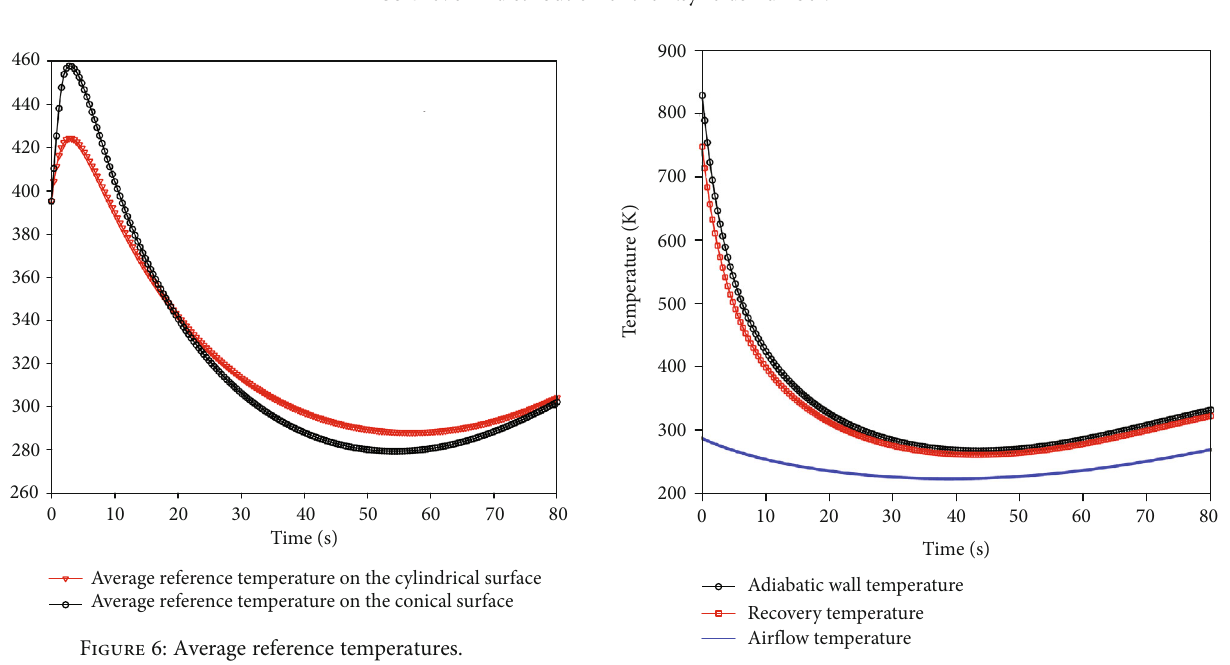
Figure 7: Adiabatic wall, recovery, and air fl ow